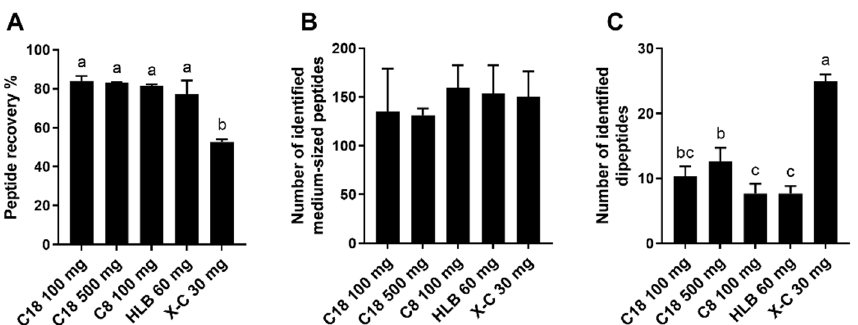
Figure 2. Recovery of proteins/peptides in high-organic fraction ( A ) and numbers of medium-sized peptides (peptide length ≥ 5 amino acid residues); ( B ) and dipeptides ( C ) identified by LC-MS from the proteolyzed almond extract collected from different SPE techniques. Reverse-phase SPE (C18 100 mg, C18 500 mg, C8 100 mg, and HLB 60 mg) was conducted using TFA as a modifier. Mixed- mode SPE (X-C-30 mg) was washed with 0.1% formic acid (aqueous fraction) and eluted with 80% ACN containing 1% ammonia for recovering peptides (high-organic fraction). Data are presented as mean ± standard deviation ( n = 3). Different lowercase letters represent a significant difference at p < 0.05.